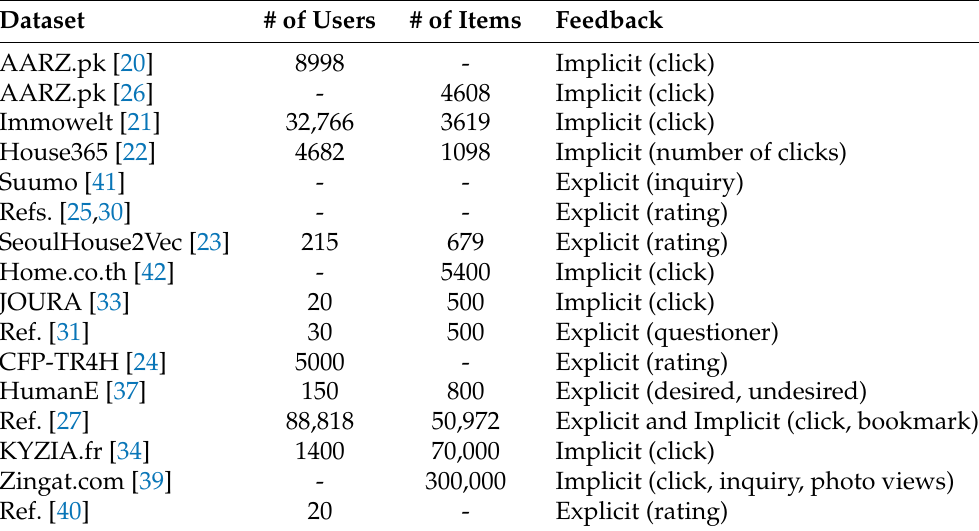
Table 5. The descriptions of datasets used in the selected